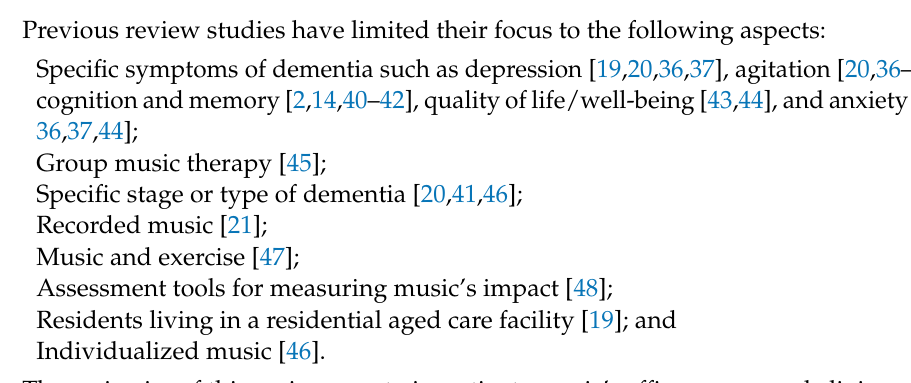
Figure 1. Benefits of music treatment for people living with dementia (PWD).